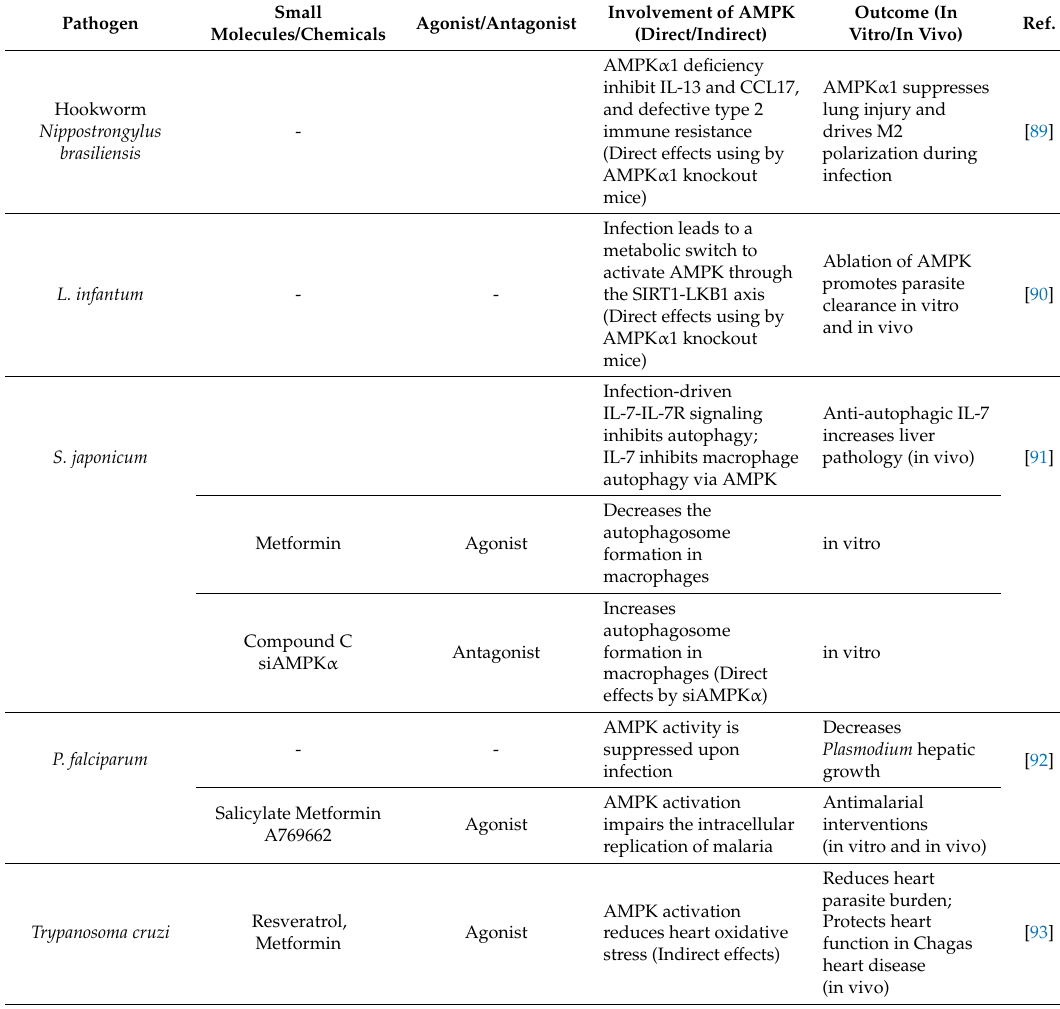
Table 4. The role of AMPK in parasitic